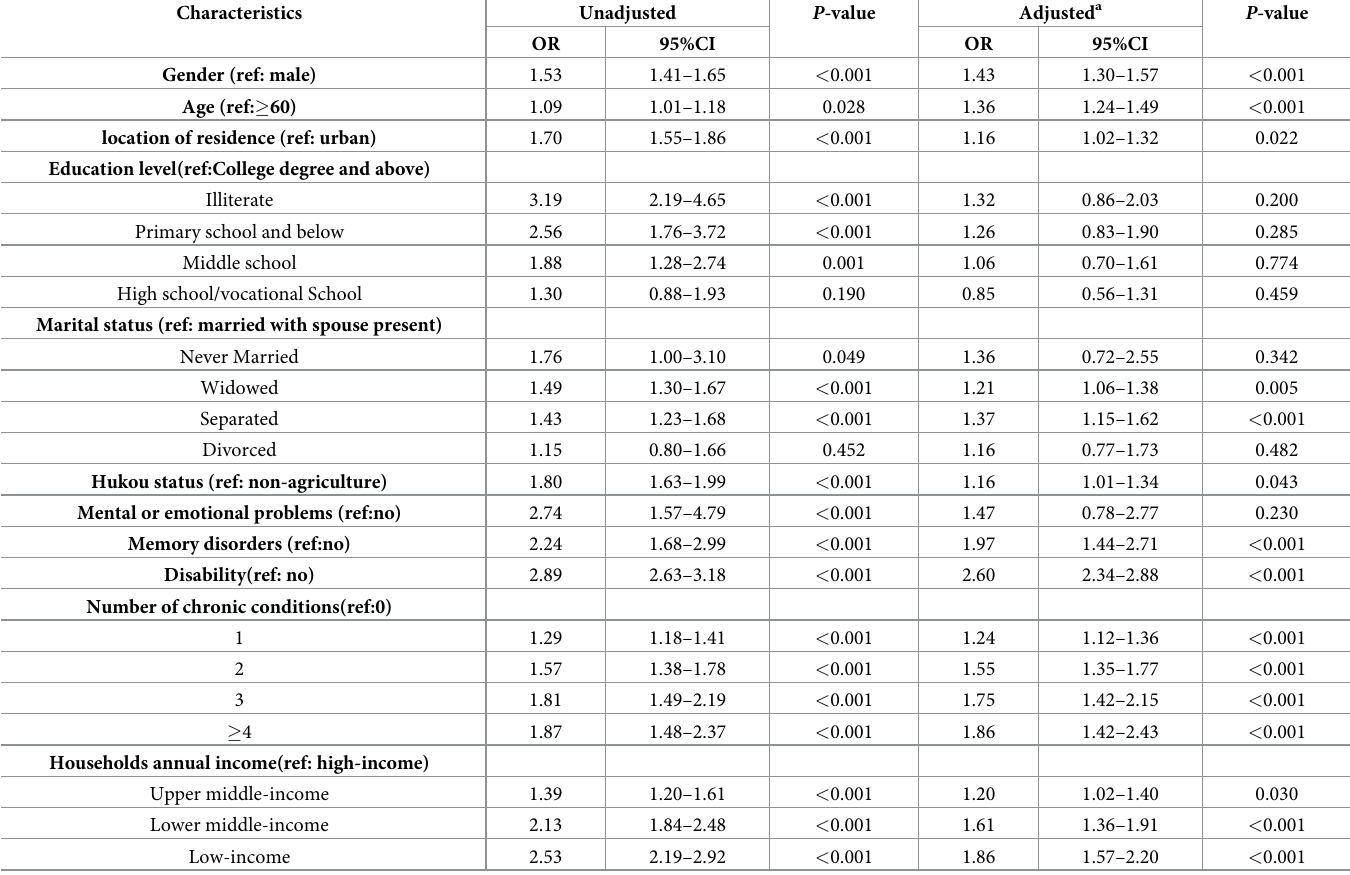
Table 2. Crude and adjusted odds ratios (OR) for the associations between self-care disability and depressive symptoms. Characteristics Unadjusted